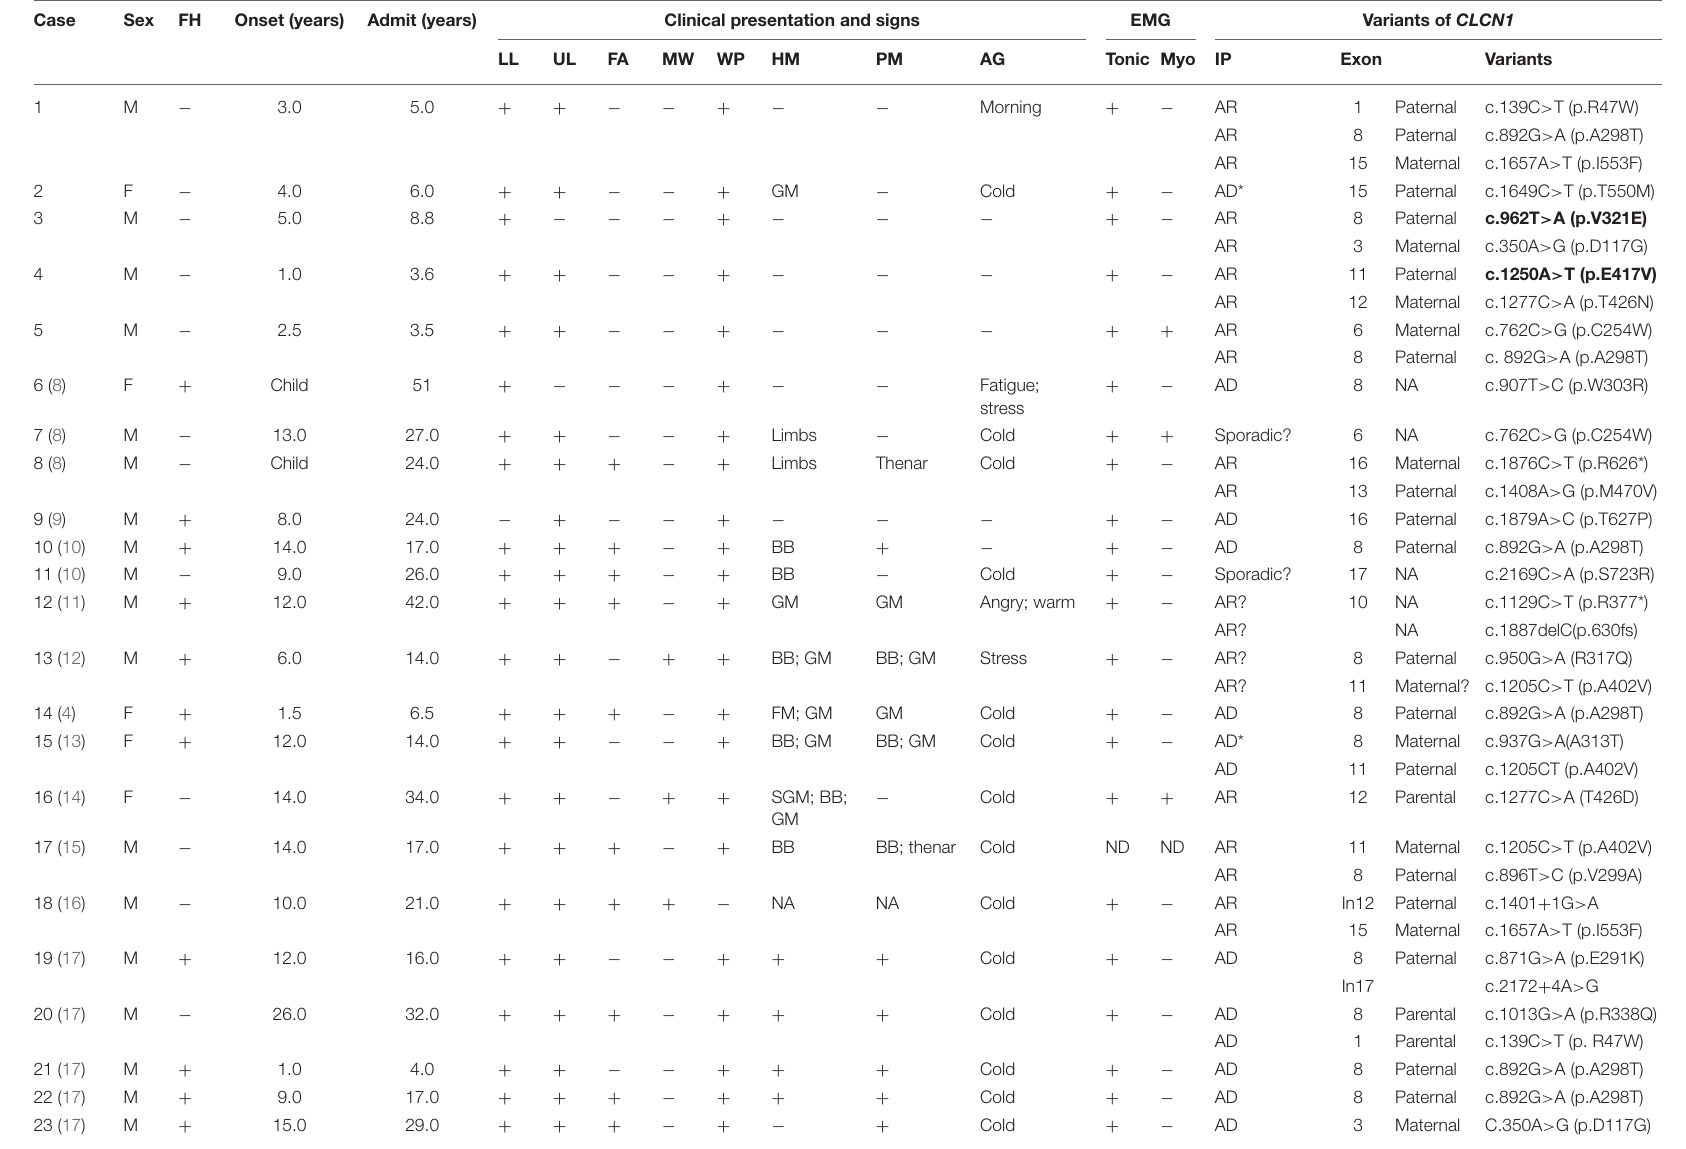
TABLE 1 | The clinical presentation, laboratory, and electrophysiological finding and molecular results of CLCN1 -mutated patients in China.